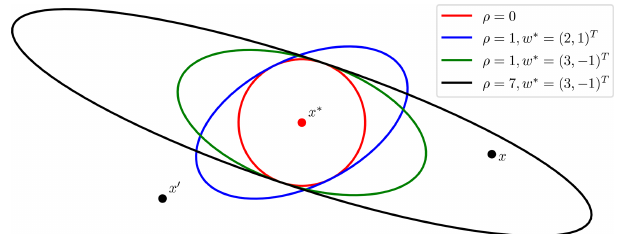
Figure 3. Equicovariance ellipses from the wind-informed kernel with various wind vectors w ∗ and values of ρ . The wind values are taken at the test input x ∗ , but the covariance function k is evaluated also for each pair of observations x and x (cid:48)